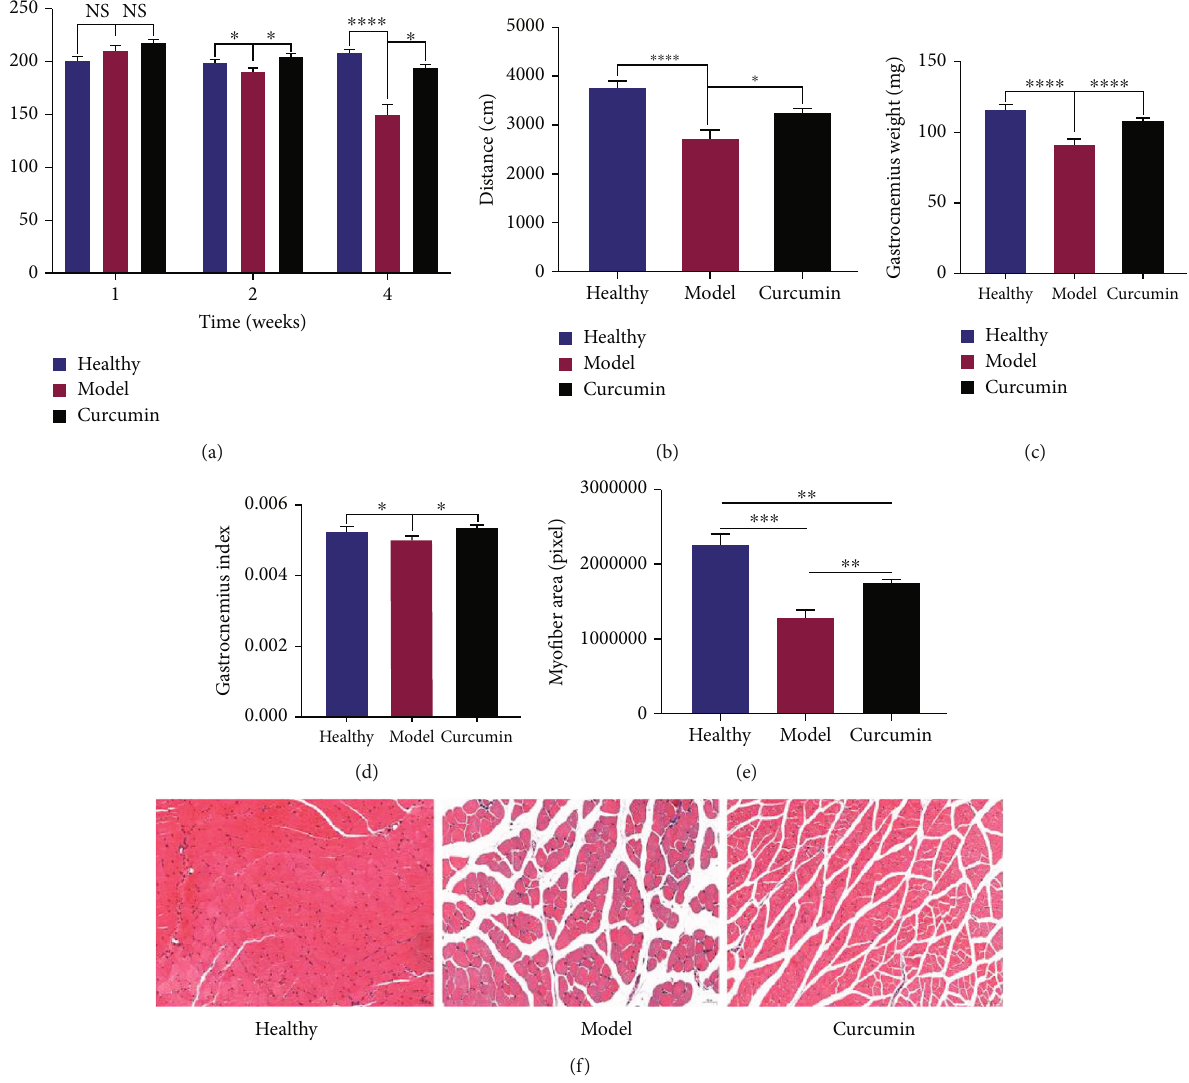
Figure 4: Curcumin reduces skeletal muscle loss and improved muscle function in tumor-bearing mice. (a) Statistical analysis of forelimb grip strength of three groups of mice at 0, 2, and 4 weeks after intervention ( n = 8 /group). (b) Statistical analysis of movement distance within 5min in three groups of mice at the end of the experiment ( n = 8 /group). (c) Statistical analysis of gastrocnemius muscle weight in three groups of mice at end of the experiment ( n = 8 /group). (d) Comparative analysis of the gastrocnemius index of the three groups of mice at the end of the experiment ( n = 8 /group). (e) Statistical analysis of muscle fi ber cross-sectional area in gastrocnemius HE sections of three groups of mice ( n = 5 /group). (f) HE staining analysis of gastrocnemius muscle in three groups ( × 200 magni fi cation; scale bar: 50 μ m, n = 5 /group). NS: not signi fi cant; ∗ p < 0 : 05 , ∗∗ p < 0 : 01 , ∗∗∗ p < 0 : 001 , and ∗∗∗∗ p < 0 : 0001 by t -test, compared to the model group. Data was shown as mean ± standard errorsof themean